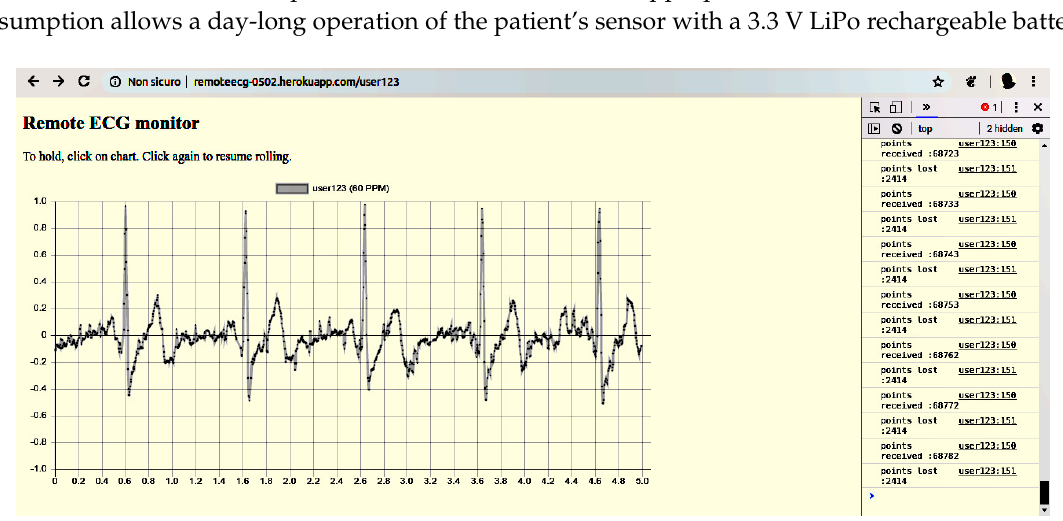
Figure 1. ECG visualization on doctor’s display. Both the laptop and the sensor are in Italy, while the relay server is geolocated in Ireland; on the right side, the report about transfer/loss